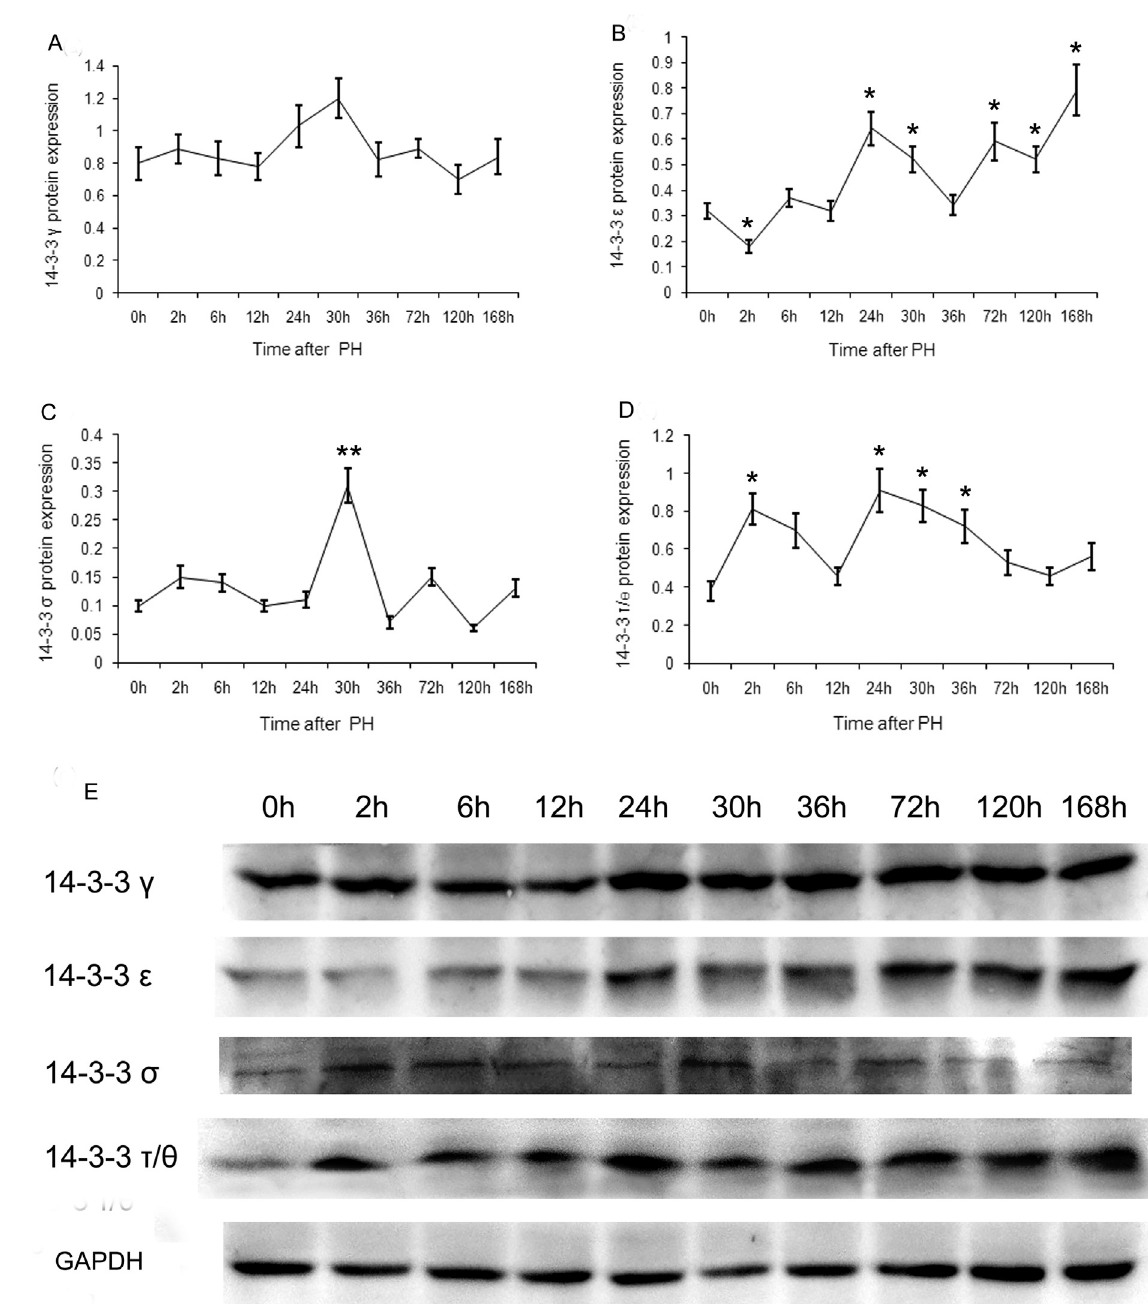
Figure 1 - Expression of 14-3-3 (cid:2) , (cid:3) , (cid:4) and (cid:5) / (cid:6) . Time curves for the expression (A) 14-3-3 (cid:2) , (B) (cid:3) , (C) (cid:4) and (D) (cid:5) / (cid:6) at each time point after PH, analyzed by western blotting. The data are presented as means (cid:12) SD (n=3). Student’s t -tests were used for analyzing the expression difference between 0 h and the other time points after PH. * p < 0.05, ** p < 0.01 versus 0 h. (E) Western blot detection of 14-3-3 (cid:2) , (cid:3) , (cid:4) and (cid:5) / (cid:6) at the respective time points after PH. GAPDH was used as an internal